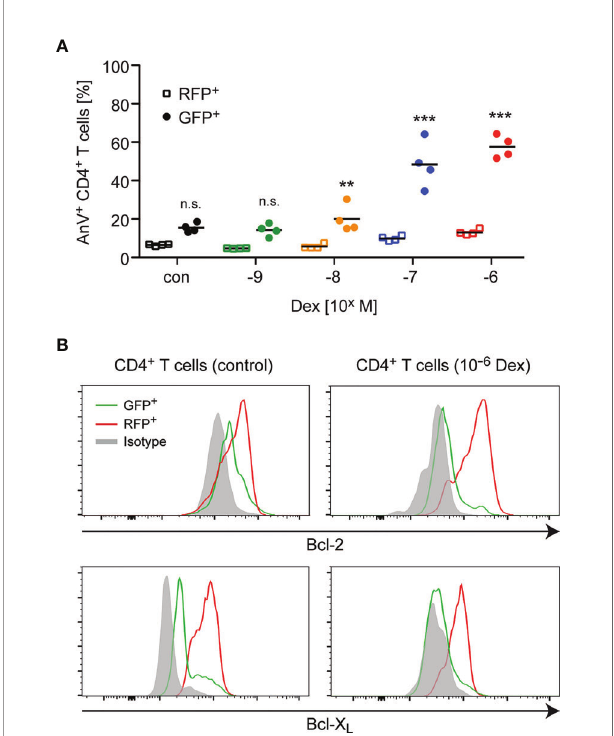
FIGURE 2 | Apoptosis sensitivity of naïve and antigen-primed effector T cells. (A) Percentages of AnnexinV + (AnV + ) cells amongst (naïve) GFP + and (antigen-primed) RFP + CD4 + T cells after 3 days of cell culture in the presence of the indicated concentrations of Dex for the last 24 hrs. No Dex was added to the cell culture under control (con) conditions. The experimental setup corresponds to the one illustrated in Figure 1A . Open symbols refer to RFP + cells and fi lled symbols refer to GFP + cells. N=4. Statistical analysis was performed by One-way ANOVA followed by a Newman-Keuls Multiple Comparison test. Levels of signi fi cance (depicted for each comparison between RFP + and GFP + cells): n.s. = not signi fi cant; **p < 0.01; ***p < 0.001. (B) Intracellular stainings of Bcl-2 or Bcl-X L in (naïve) GFP + and (antigen-primed) RFP + CD4 + T cells cultured in the absence (control) or presence of 10 -6 M Dex for the last 24 hrs according to the experimental scheme depicted in Figure 1A . Staining with an mIgG2b antibody served as an isotype control. One representative analysis for each condition is depicted as overlayed